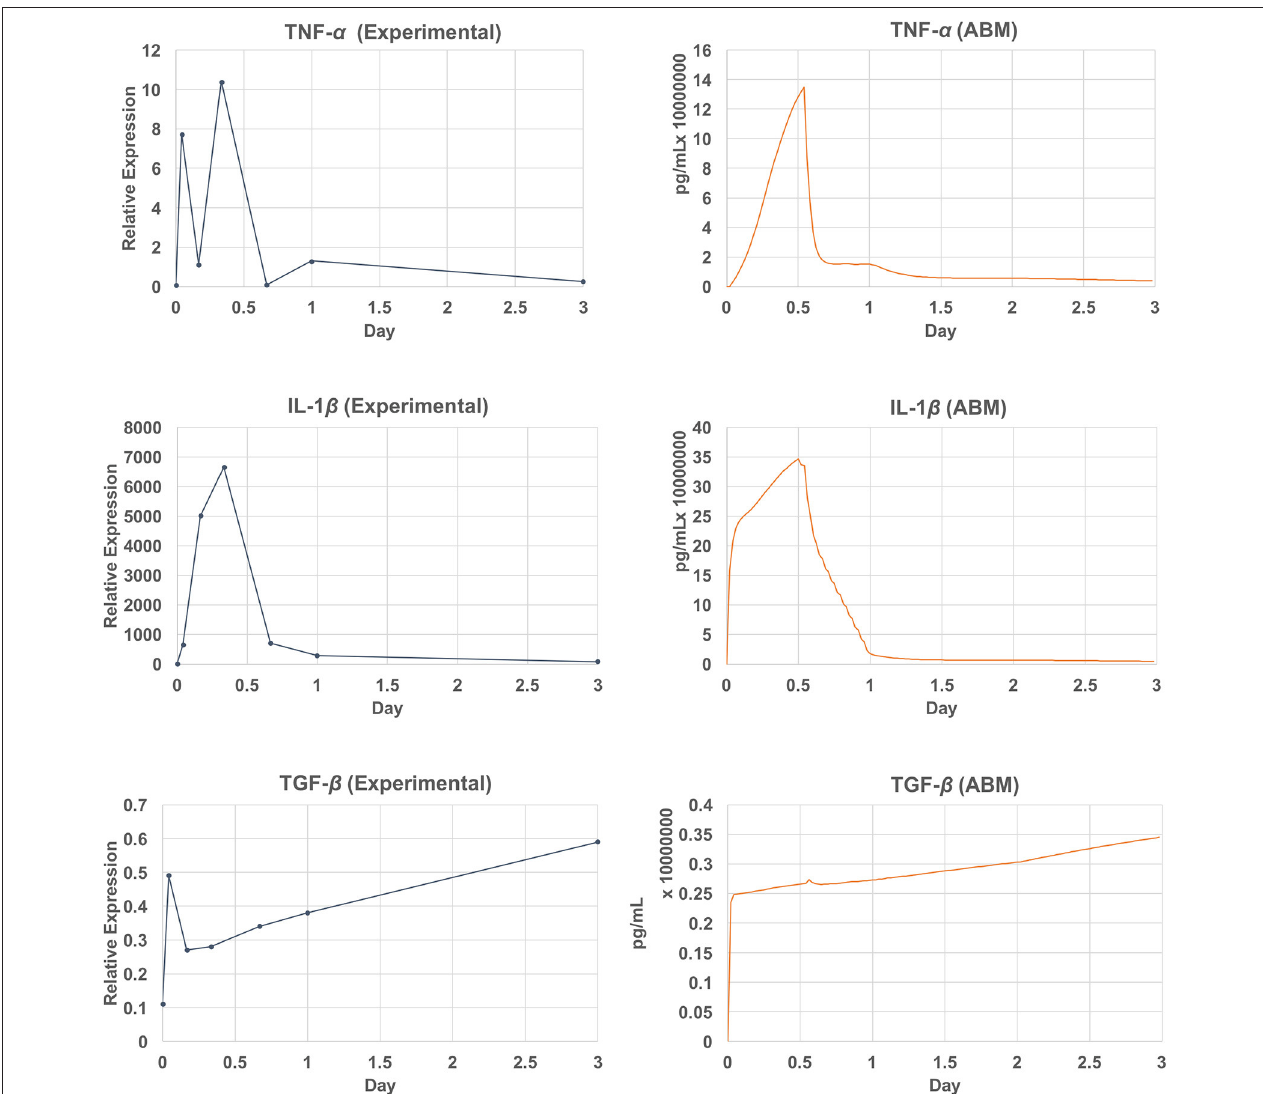
FIGURE 9 | Empirical data vs. simulation output plot. Qualitative verification of the model output (left) against empirical data (Lim et al., 2006; Welham et al., 2008) (right) . The set of verified chemicals includes TNF- α , TGF- β , and IL-1 β . component tracks 17 million cells and process 1.7